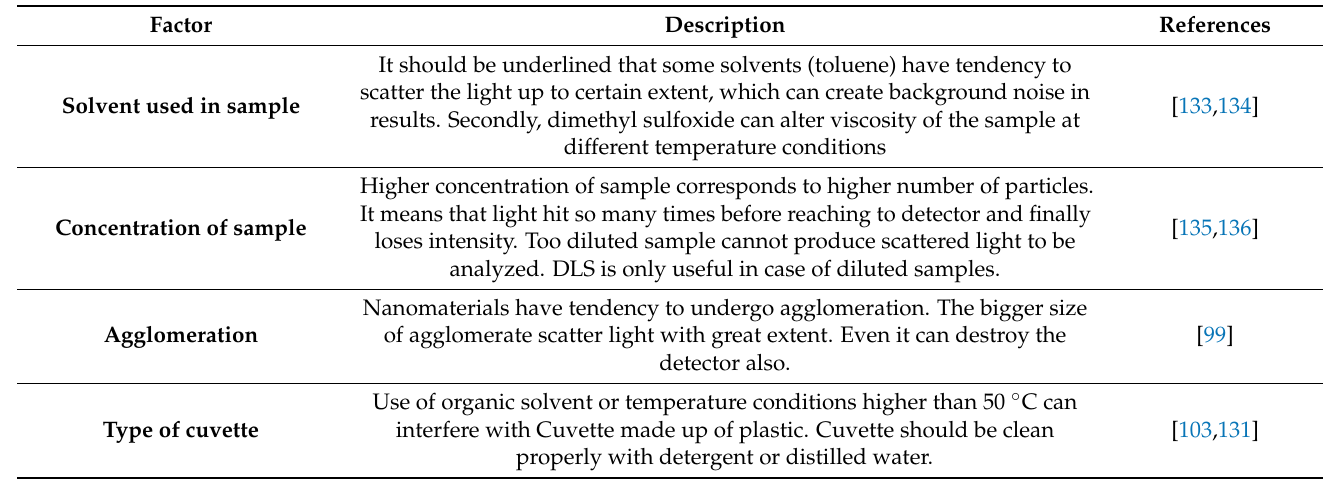
Table 3. Factors affecting accuracy of DLS